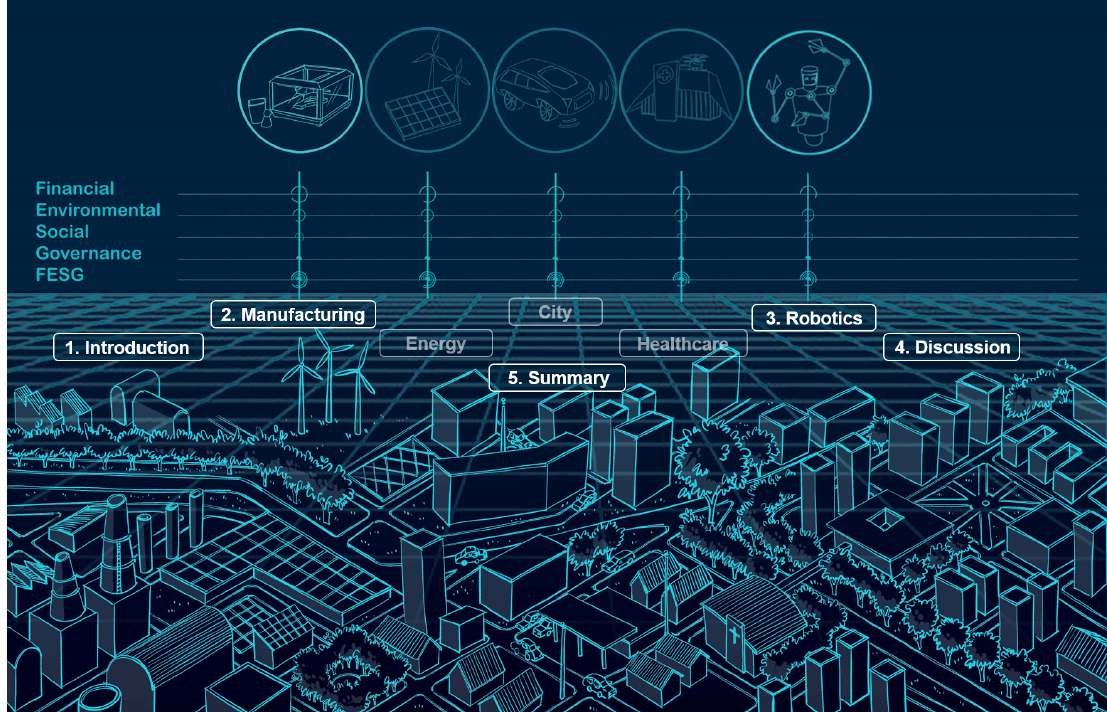
Figure 1. Overview of the